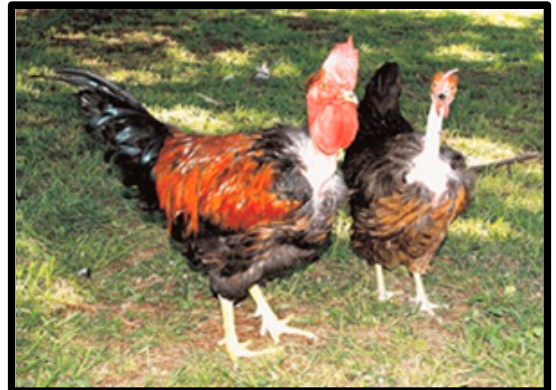
Figure 1. Naked Neck chicken breeds. Source: [42].